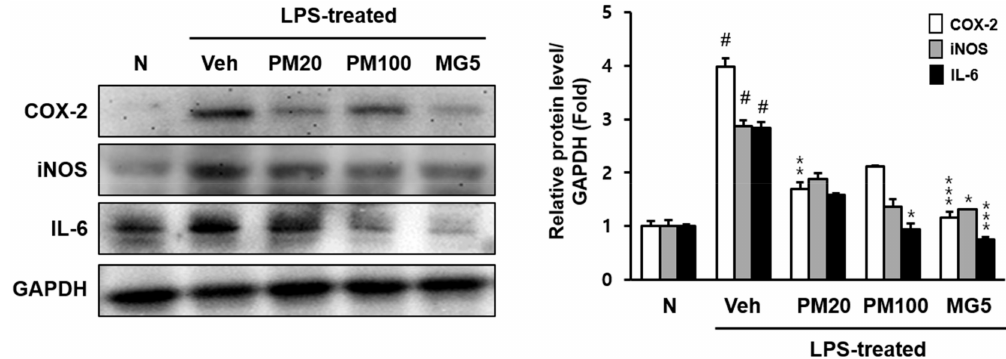
Figure 6. COX-2, iNOS, and IL-6 protein levels in the kidney. N, normal mice; Veh, vehicle-administered and LPS-treated mice; PM20, P. su ff ruticosa 20 mg / kg body weight-administered and LPS-treated mice; PM100, P. su ff ruticosa 100 mg / kg body weight-administered and LPS-treated mice; and MG5, methyl gallate 5 mg / kg body weight-administered and LPS-treated mice. The protein levels of COX-2, iNOS, and IL-6 were quantified using CS analyzer software. GAPDH was used as loading control. A representation of three experiments that yielded similar results. One-factor ANOVA: # p < 0.05 versus normal mice; * p < 0.05, ** p < 0.01 and *** p < 0.001 versus veh (vehicle-administered and LPS-treated mice). Bars indicate standard errors of means